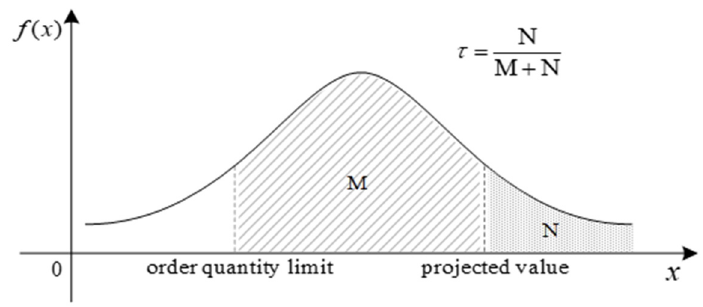
Figure 2. Estimation process for constrained observations using PD.